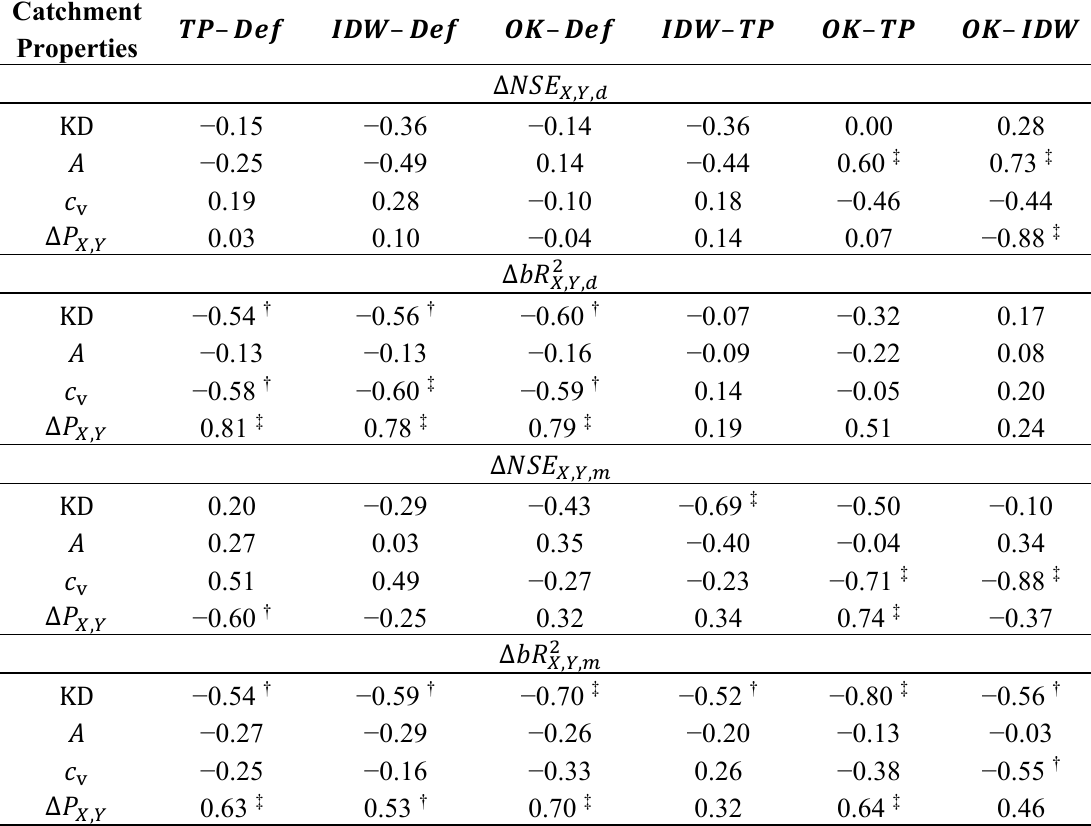
. (cid:3025),(cid:3026),(cid:3047)